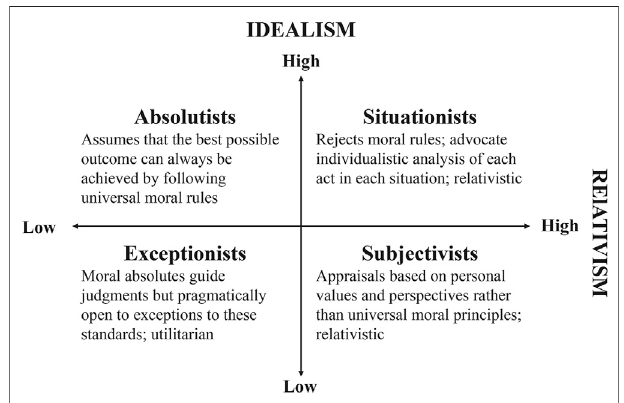
FIGURE 5 | Taxonomy of ethical ideologies (Source: Forsyth, 1980, p.